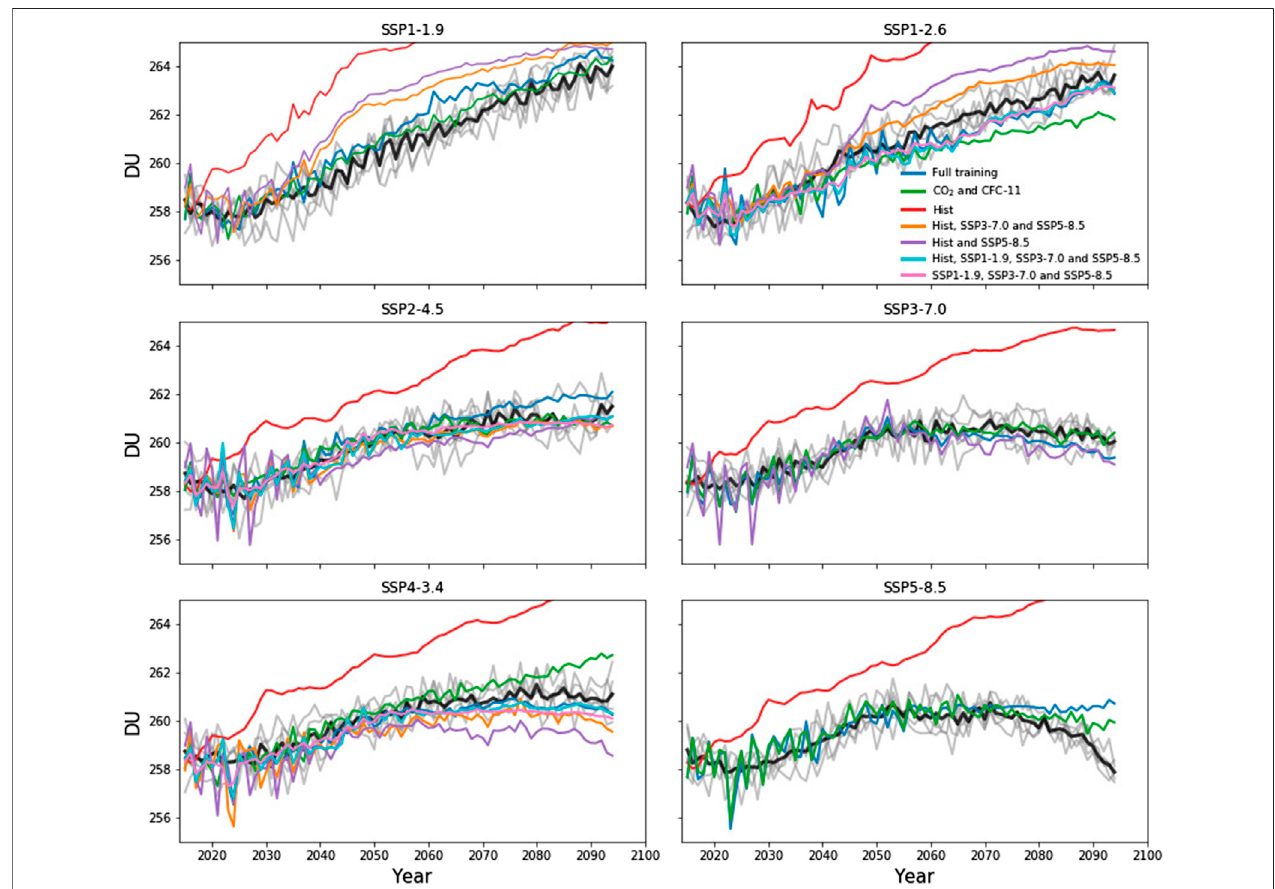
FIGURE 5 | Predictions of tropical stratospheric column ozone made using the Extra Trees machine learning method using different amounts of training data.